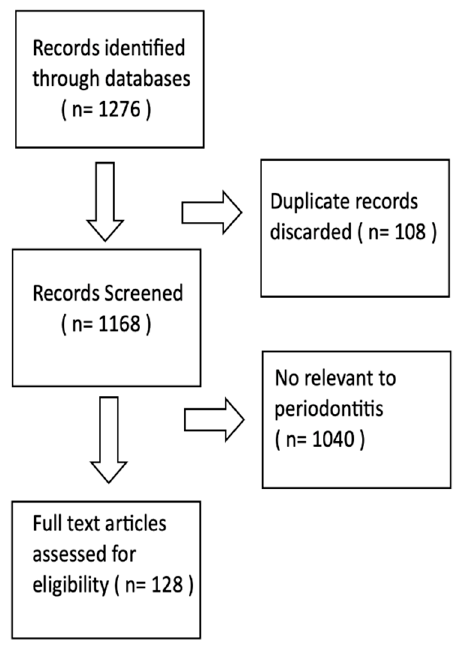
Figure 1. Flow diagram showing article selection